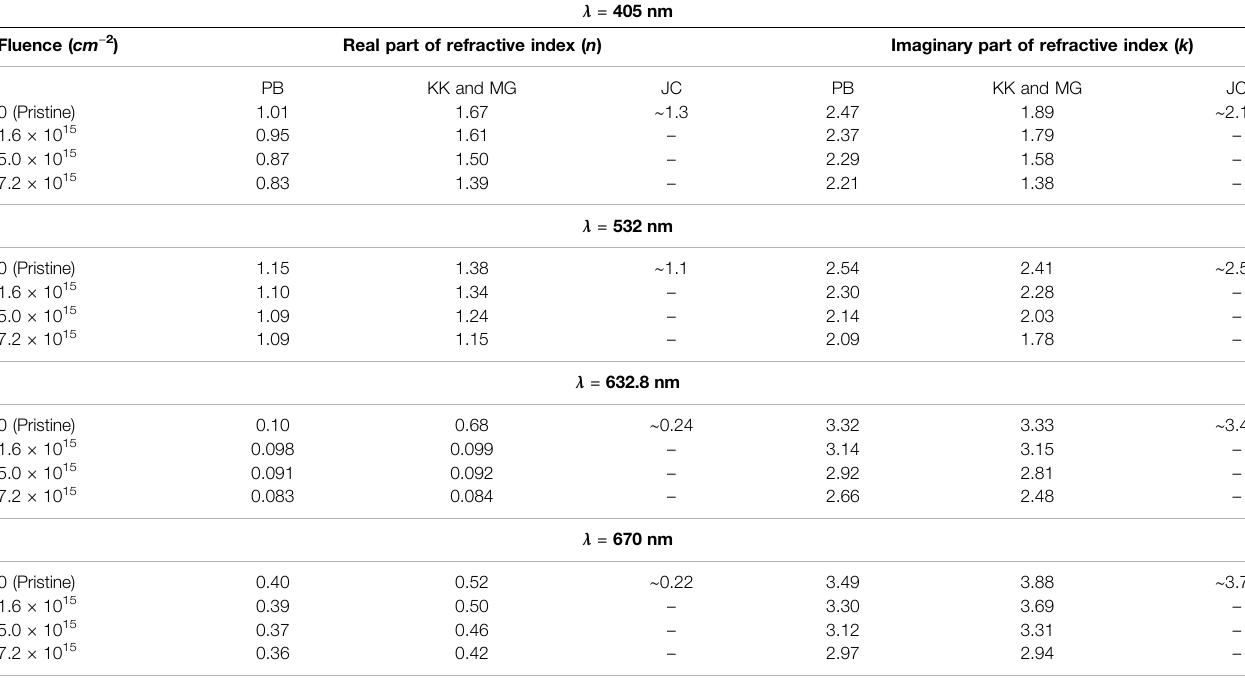
TABLE 1 | Optical constants of copper MTF where PB: pseudo- Brewster angle technique, KK: Kramers-Kronig technique, MG: Maxwell-Garnett technique, JC: Johnson and Christy [6] data.